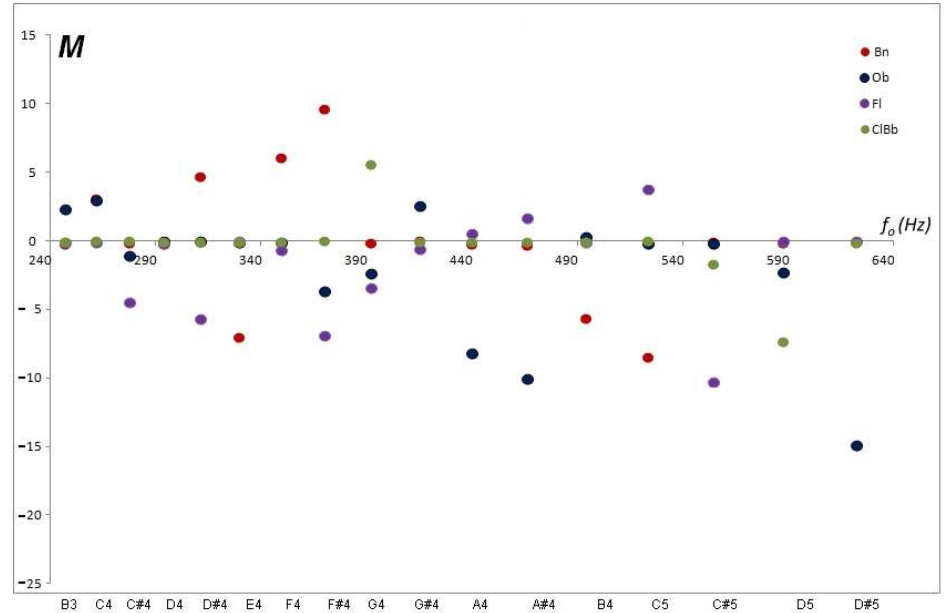
Figure 10. Monotony ( M ) of aerophones for common